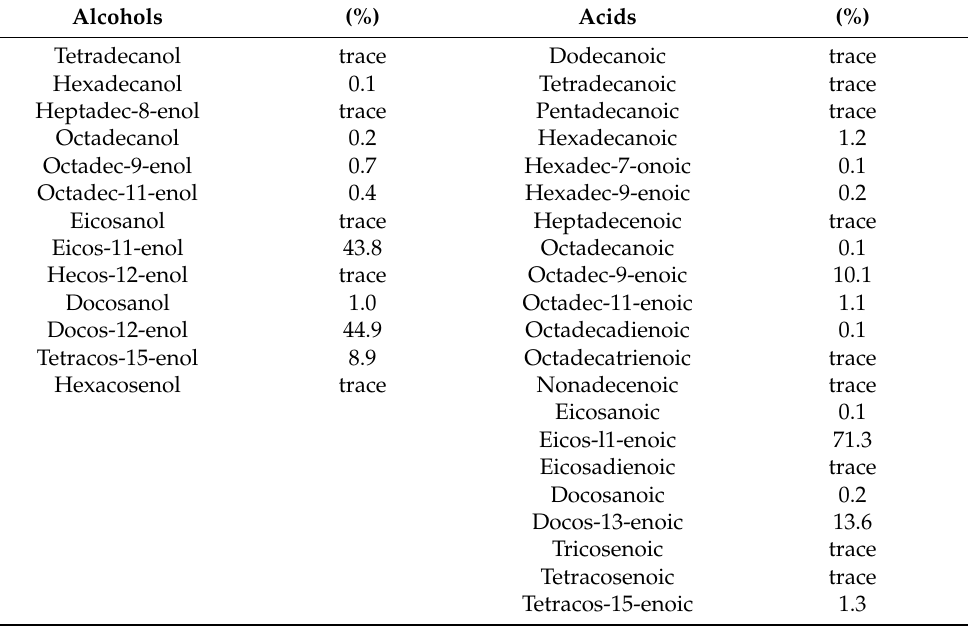
Table 2. The composition of free fatty alcohols and fatty acids derived from jojoba oil.